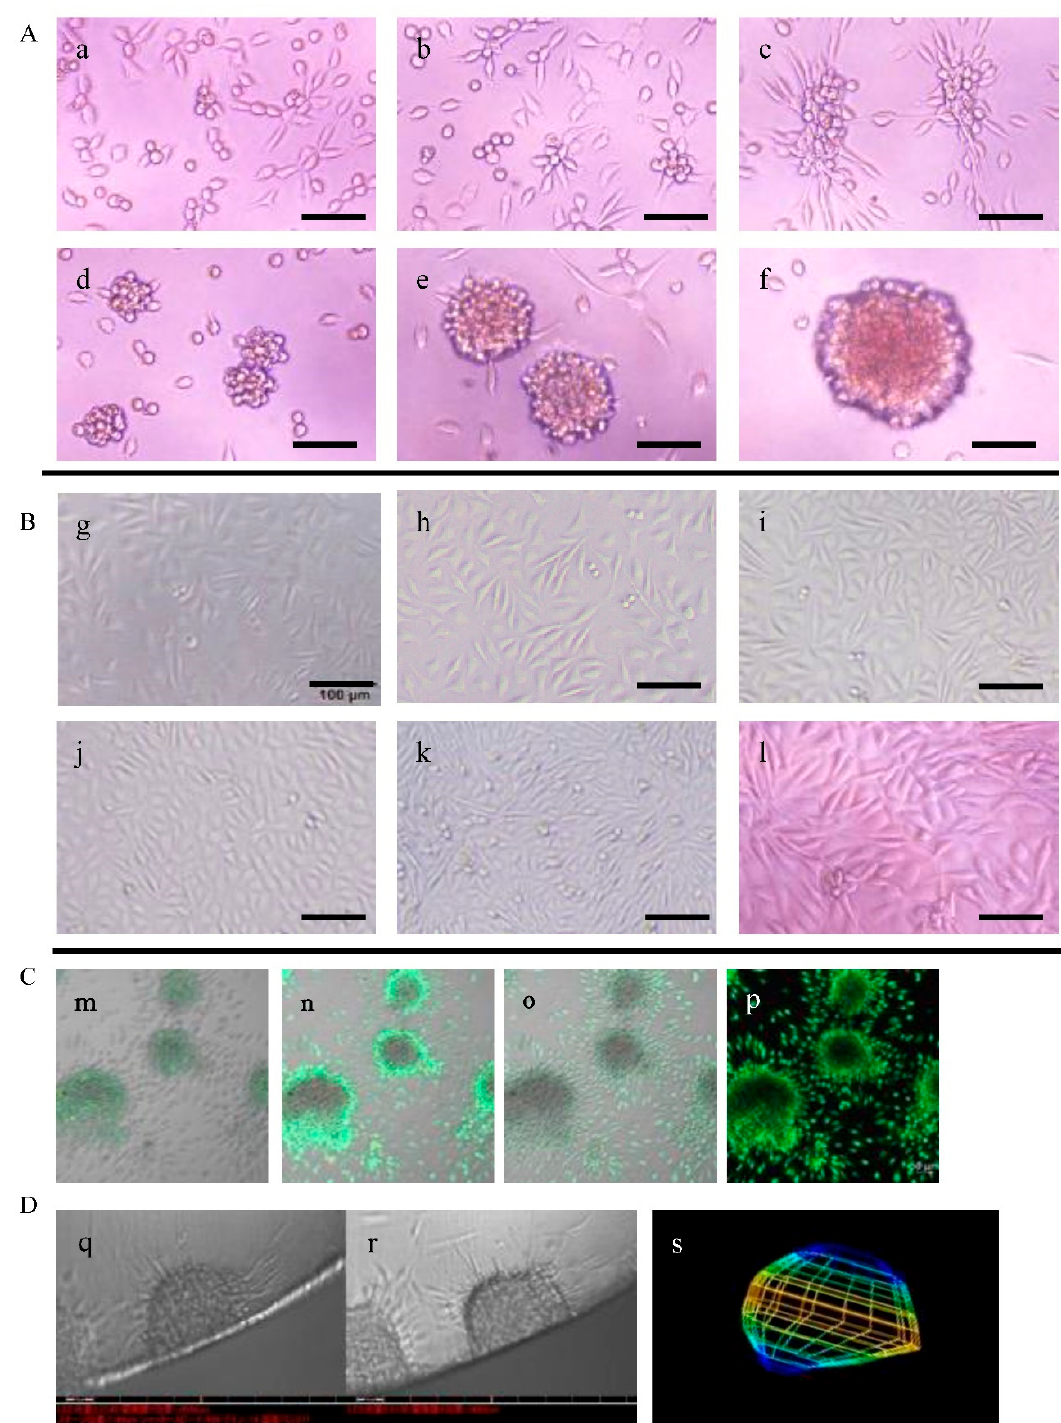
Figure 1. Results of cell aggregate induced by adding of KP24 peptide ( × 10 and scale bar: 100 µ m). ( A ) Addition of peptide. ( B ) Control—incubation time, 1–6 days; a and g, 1 day; b and h, 2 days; c and i, 3 days; d and j, 4 days; e and k, 5 days; f and l, 6 days; cell density, 5.0 × 10 4 cells/mL; peptide concentration, 1.0 mg/mL. ( C ) Live/dead assay photographs of confocal laser scanning microscope (KP24, 6 days)—m, top; n, center layer; o, bottom observation; p, live/dead assay image. ( D ) Microphotograph of Mil-Cell analysis and 3D analysis—q, bottom view; r, side view; s, 3D image analysis.